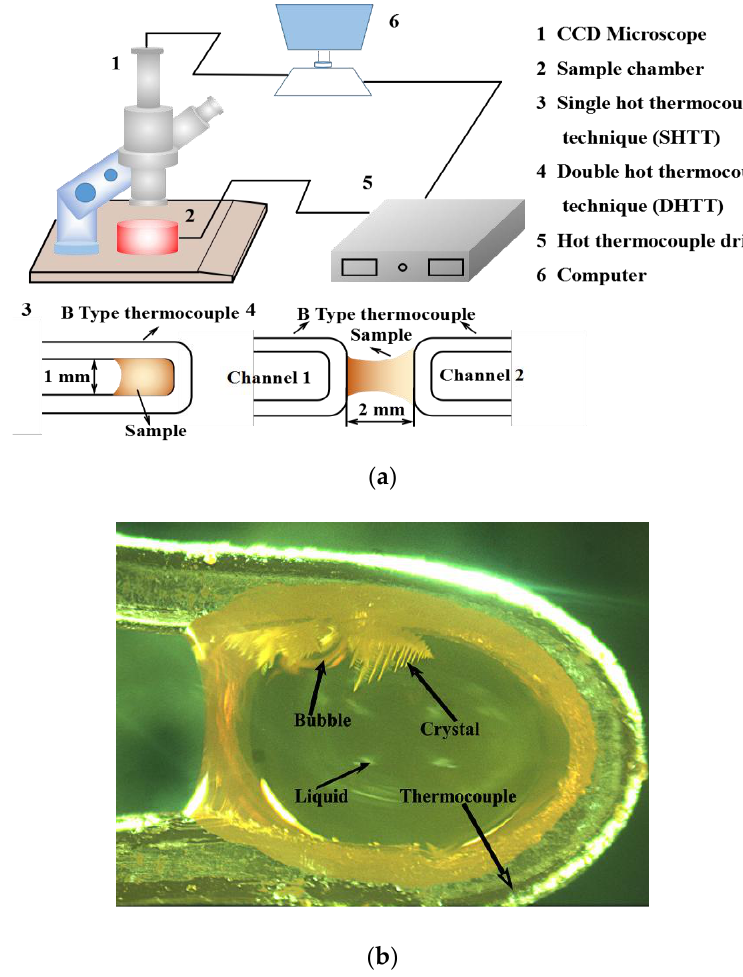
Figure 3. Schematic diagram of the single hot thermocouple technique (SHTT) ( a ) and crystallization process of the molten slag through SHTT ( b ).